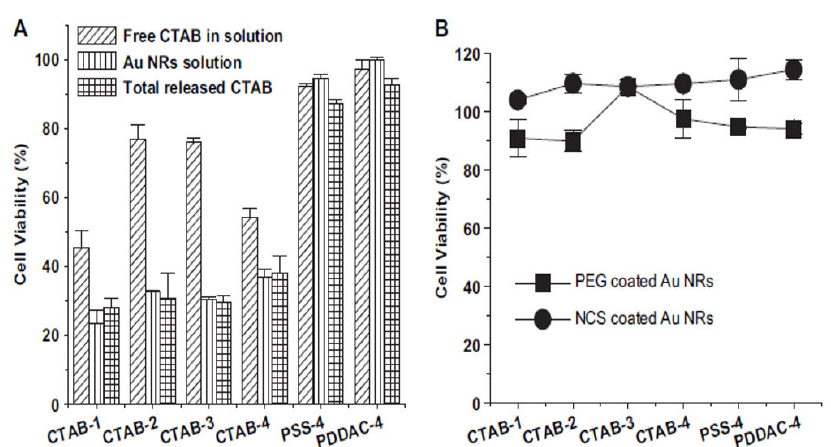
Figure 19. Cell viability after treatment with ( A ) supernatant of Au NRs suspensions and PEG. ( B ) Au NRs are coated with newborn calf serum or PEG [137]. Reprinted with permission from ref. [137]. Copyright 2010 Biomaterials.